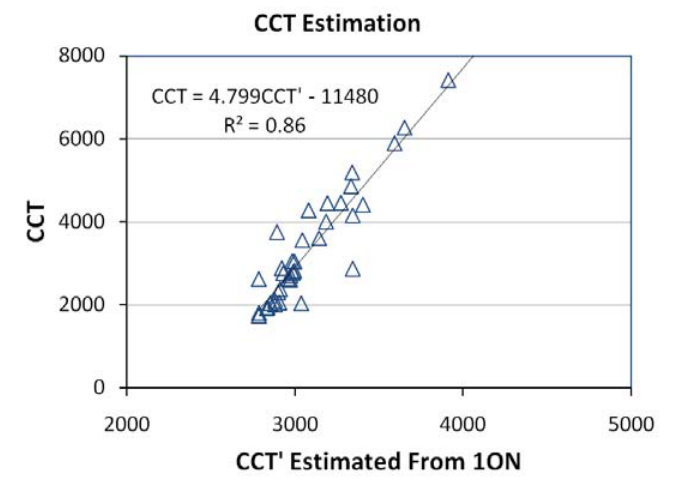
Figure 24. The 1ON estimates of CCT’ versus the CCT calculated from the ASD spectra. Linear regression yields an R 2 of